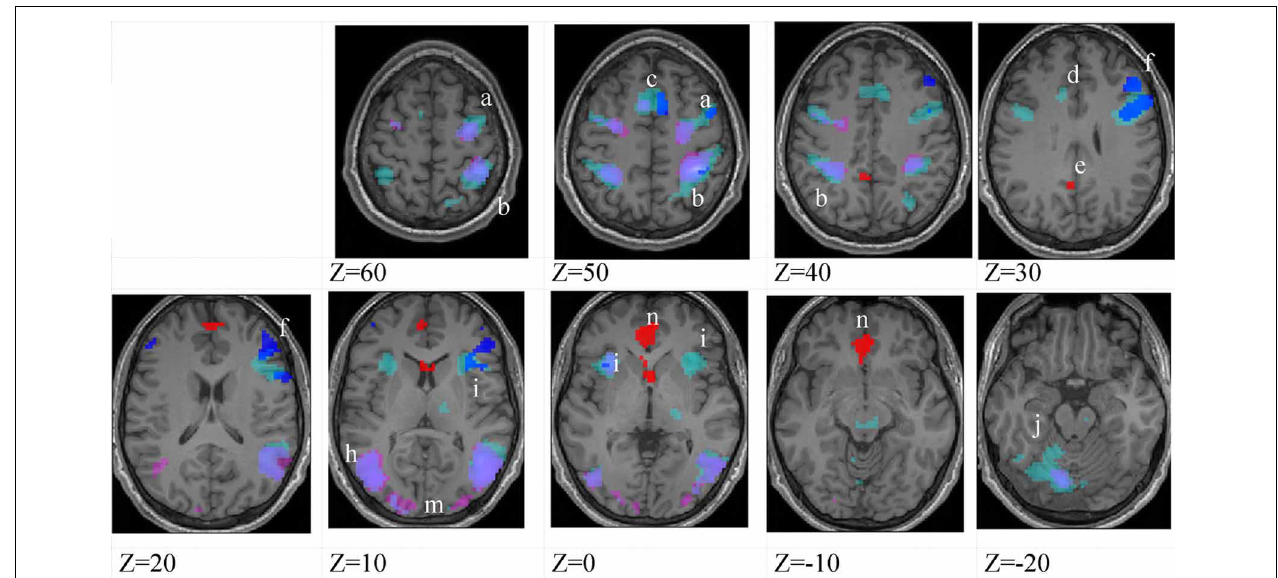
FIGURE 5 | Lower-skilled females. Second-level fMRI activations ( p < 0 . 005, FWE corrected, 25 voxels minimum cluster size) to deception identification (cyan) and direction identification (magenta) in point-light soccer video clips, relative to stimulus-matched non-biological motion (NBM) controls. Overlapping areas responding to both identification tasks appear purple. Activations above threshold (blobs) are displayed in co-registration with an individual normalized structural brain image and sampled in horizontal sections 10mm apart from z = 60 to z = − 20. In darker blue